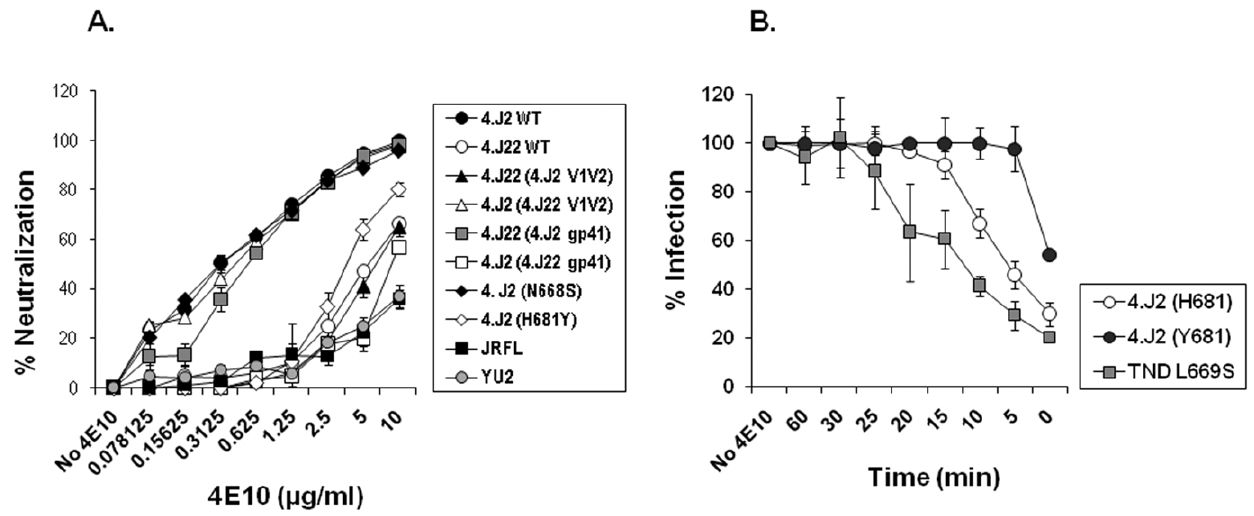
Figure 3. Effect of Y681H substitution on exposure of neutralizing epitopes in gp41 MPER. A. Neutralization sensitivity of Env- pseudotyped viruses expressing Y681 and H681 were tested against 4E10 MAb in TZM-bl cells. Percent neutralization on Y-axis against serial dilutions of 4E10 indicated on X-axis shows H681 conferring increased Env sensitivity to 4E10 MAb (and also T20; see Figure S1 and Table 1). The neutralization assays were done in duplicate in more than three independent experiments. VC stands for virus control where antibody was not added. B. Time course of 4E10 MAb neutralization of Envs. 4E10 was added in warm condition (37 u C) at different time points in TZM-bl cells which were pre- adsorbed with Env pseudotyped virus in cold condition. The percent infection is plotted on Y-axis against various time points of 4E10 addition given on X-axis. No 4E10 indicates infection of TZM-bl cells in absence of 4E10 MAb and hence serves as virus control. Note that 4E10 could neutralize 4.J2 (H681) by 50% up to 6 min as opposed to 1 min for 4.J2 (Y681). TND S669 that was earlier reported [44] for enhanced exposure of neutralizing epitopes in MPER was used as positive control.